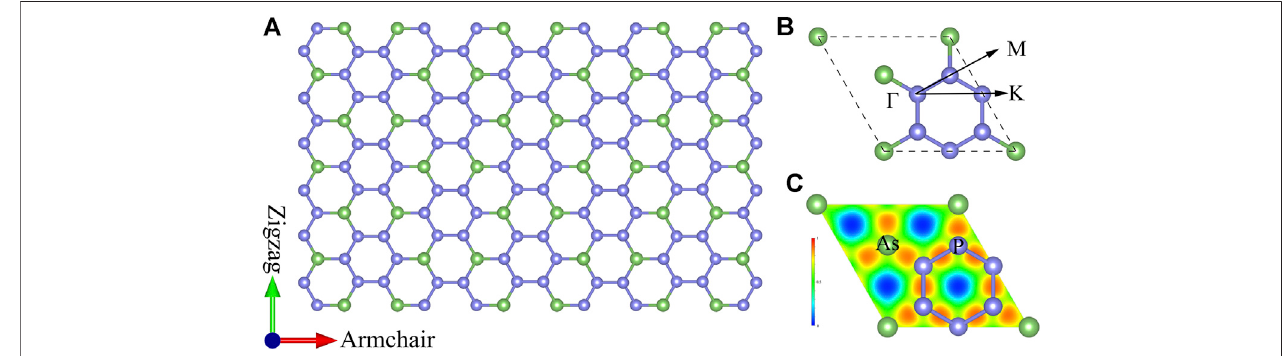
FIGURE 1 | (A) Top view of atomic structure, (B) corresponding fi rst Brillouin zone path, and (C) electronic local function for monolayer AsP 3 .